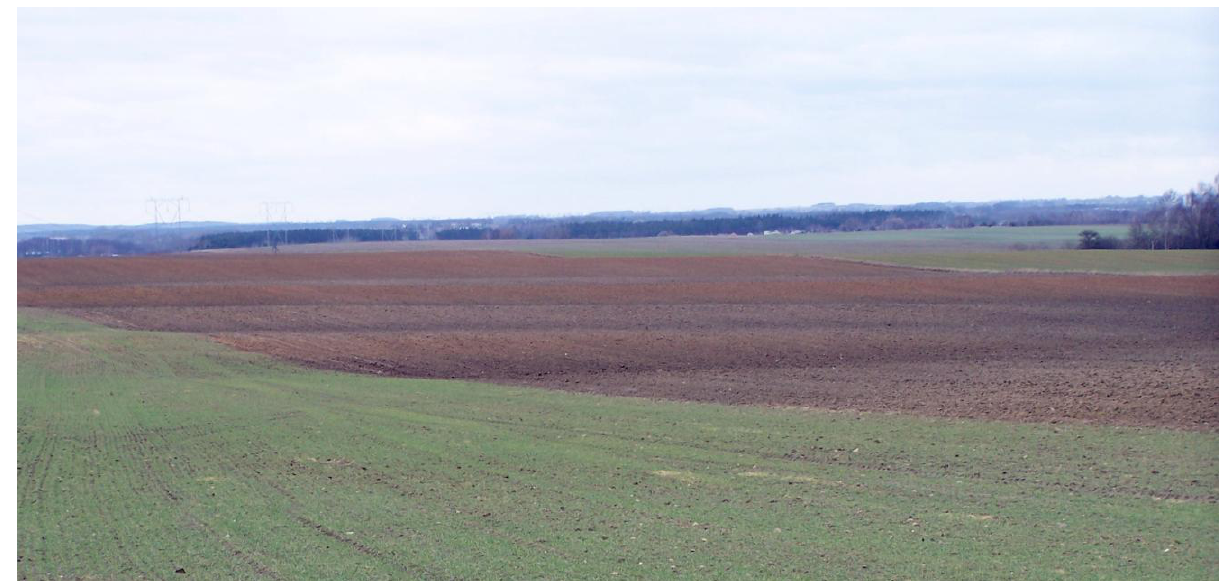
Photo 2. Troughs between glaciotectonic ridges filled with organic and mineral sediments, viewed from the east ( M. Fajer, February 2016